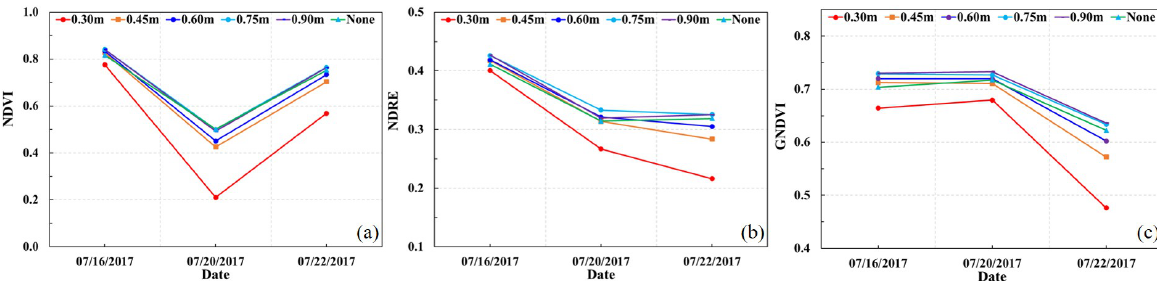
Figure 7. Temporal change of canopy NDVI, NDRE and GNDVI with different water treatment during the experiment. The indices were averaged over each rooting depth after soil removal